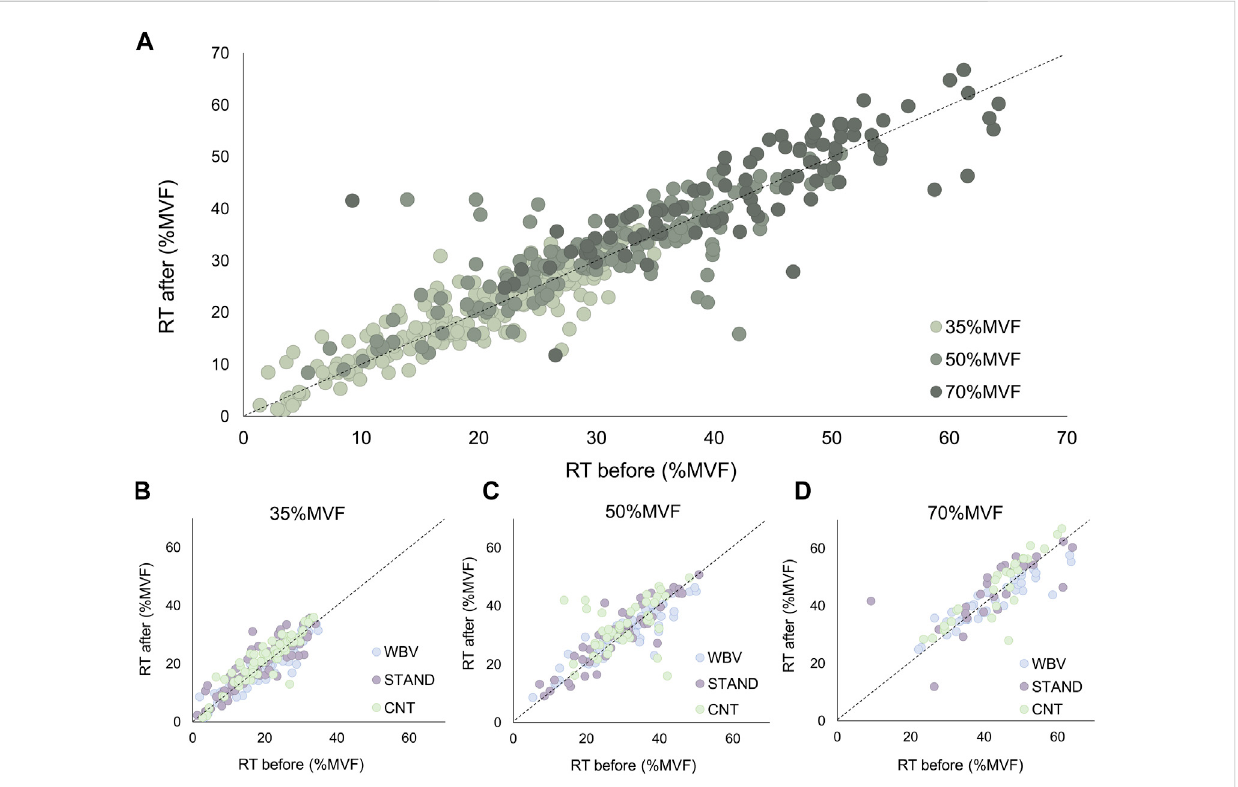
FIGURE 5 Motor unit recruitment threshold. The scatter plots of the recruitment threshold before (abscissa) and after (ordinate) each condition. It was displayed for the overall results (A) , 35%MVF (B) , 50%MVF (C) , and 70%MVF (D)